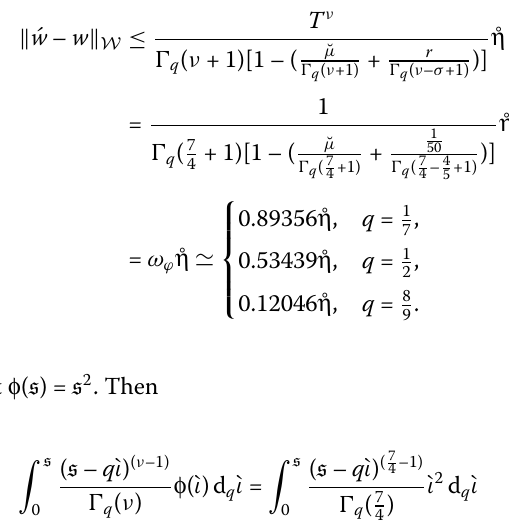
Table 4 and Fig. 4 show these results and graphical representation of Theorem 4.1 problem (17) is UHS such